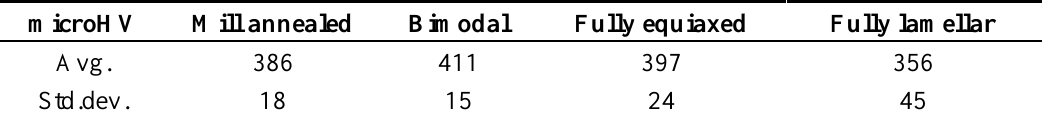
Table 1. Mean and standard deviation of microhardness results for the different examined microstructures.